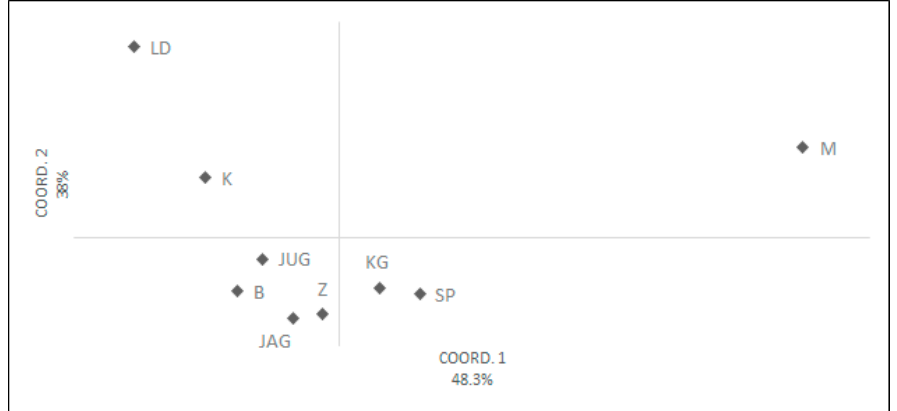
Figure 3. PCA on nSSRs conducted for seed orchards.